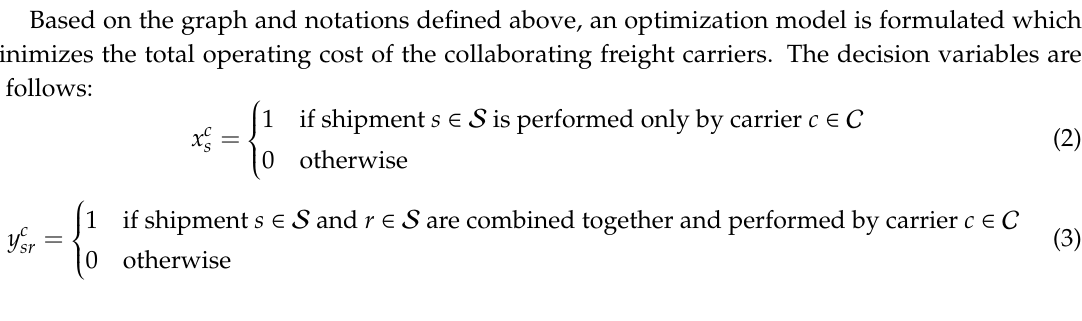
Figure 3. Time window framework for both single and combined shipments.